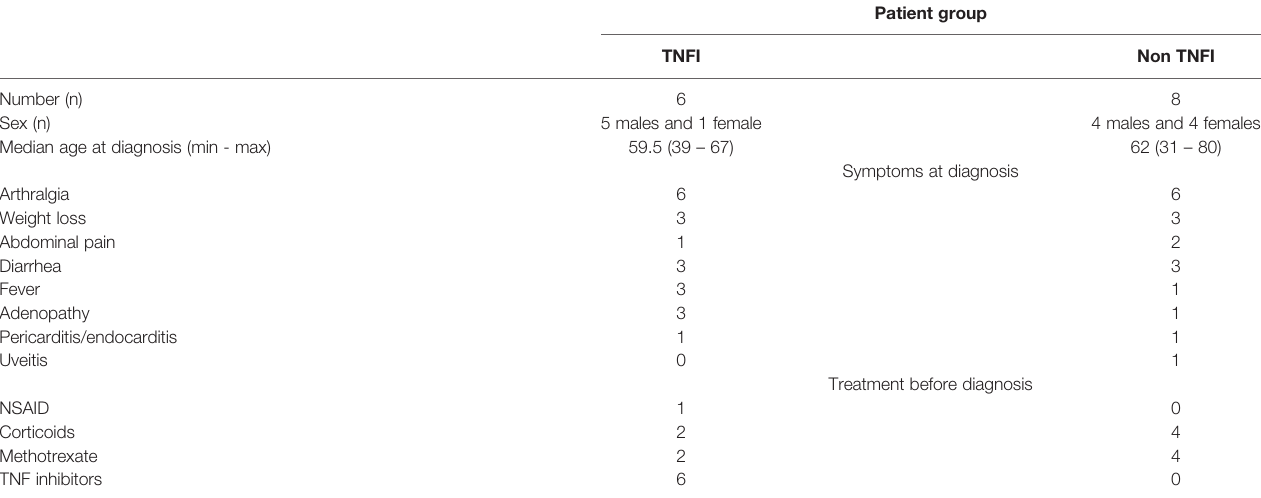
TABLE 1 | Characteristics of Whipple ’ s disease